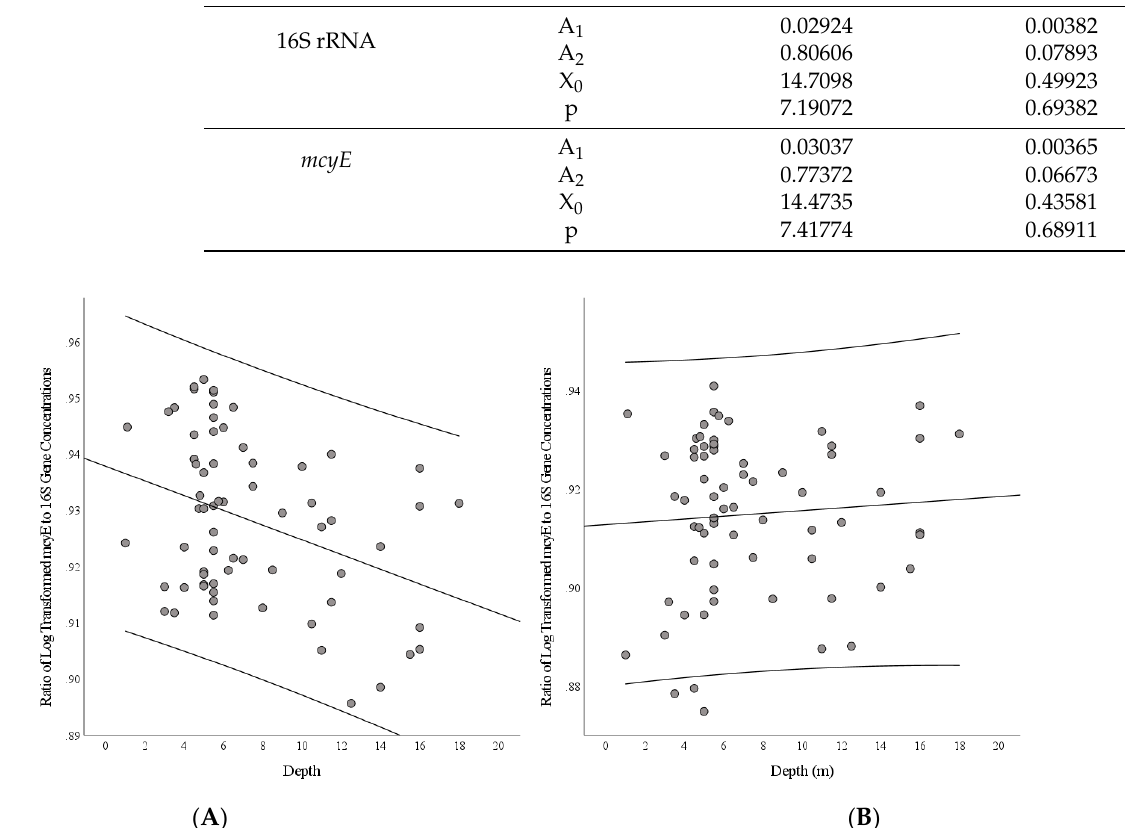
Figure 6. Ratio of the log 10 of M. aeruginosa mcyE and 16S rRNA concentration plotted against depth in meters in the near-bottom ( A ) and near-surface ( B ) at Gilmour Point, Dog Lake. Curved lines represent 95% confidence intervals.